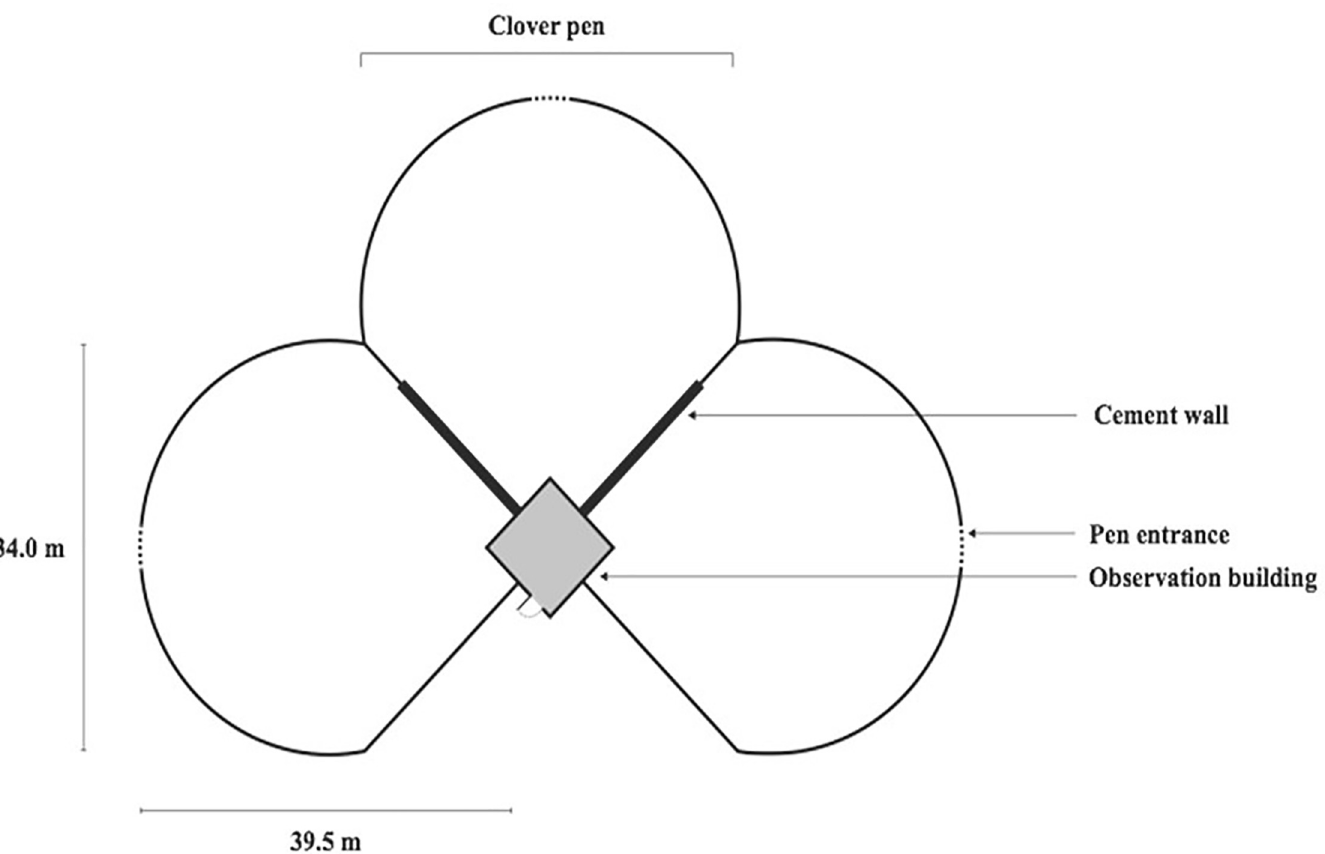
Fig 1. Schematic depicting three of the 1000 m 2 enclosures housing single or male-female pairs of coyotes within a single housing block at the USDA-National Wildlife Research Center’s Predator Research Facility (Millville, UT, USA). The enclosures are tear-drop shaped, adjoined by a common observation building at the narrow ends. Subjects could see immediate neighbors through the chain-link fence at the wider end of the enclosure but could not see neighbors towards the narrow end because of cement walls abutting the observation building. A plywood fence was erected that extended from the cement wall when needed to prevent neighbors from seeing one another at the wide ends.